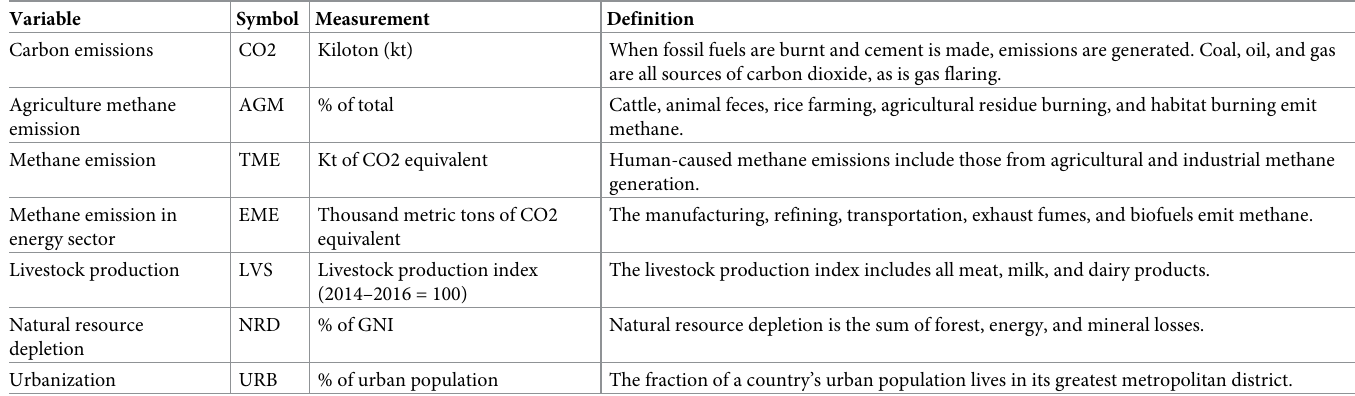
Table 1. List of